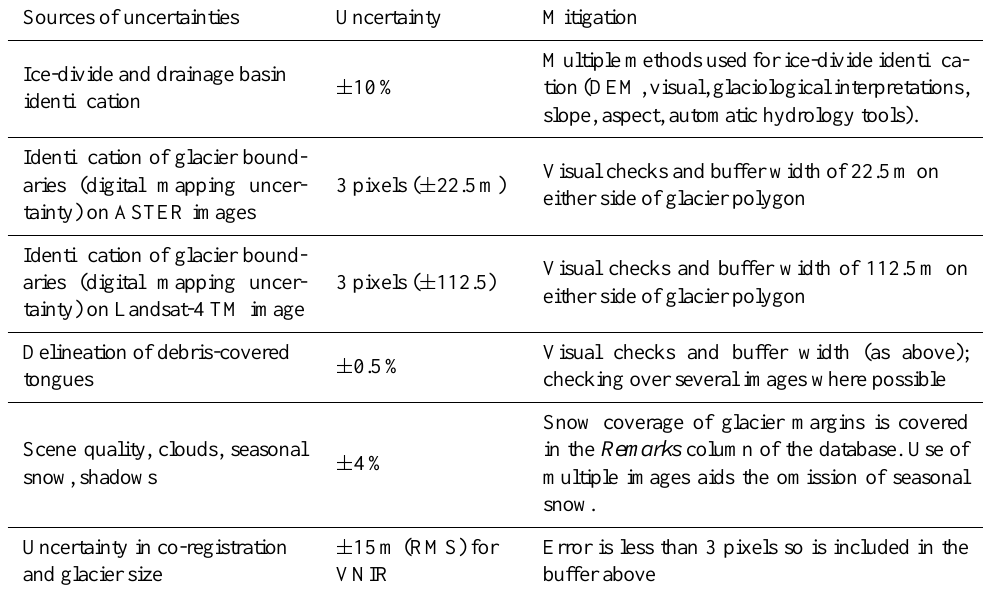
Table 2. Sources of uncertainty and mitigation in defining the area of each glacier polygon. Sources of uncertainties Uncertainty Mitigation Multiple methods used for ice-divide identifica- ± 10% tion (DEM, visual, glaciological interpretations, slope, aspect, automatic hydrology tools). Visual checks and buffer width of 22.5m